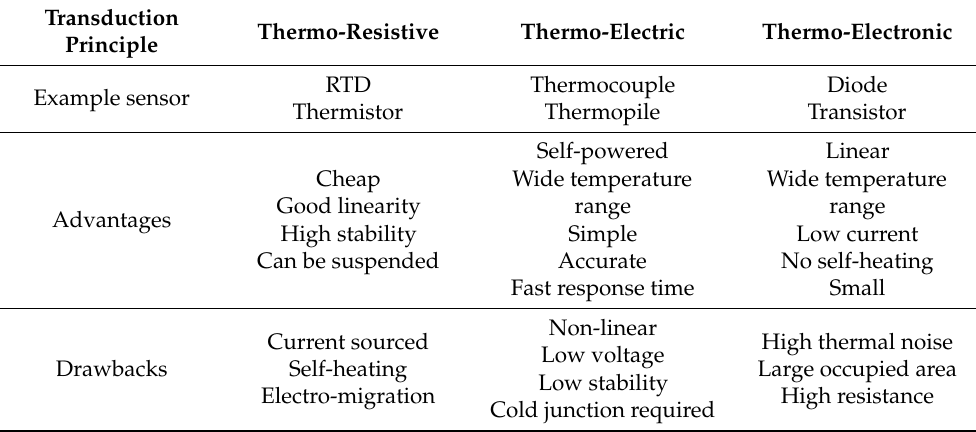
Table 2. A table summarising advantages and disadvantages of the three main methods for tempera- ture